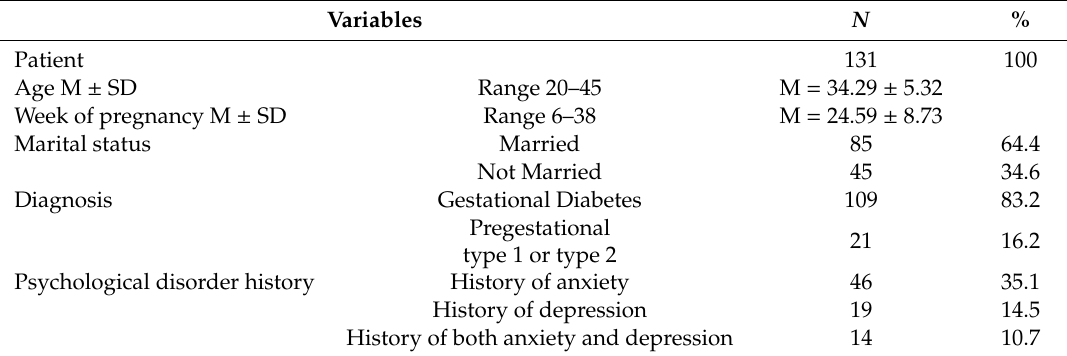
Table 1. Sociodemographic and clinical